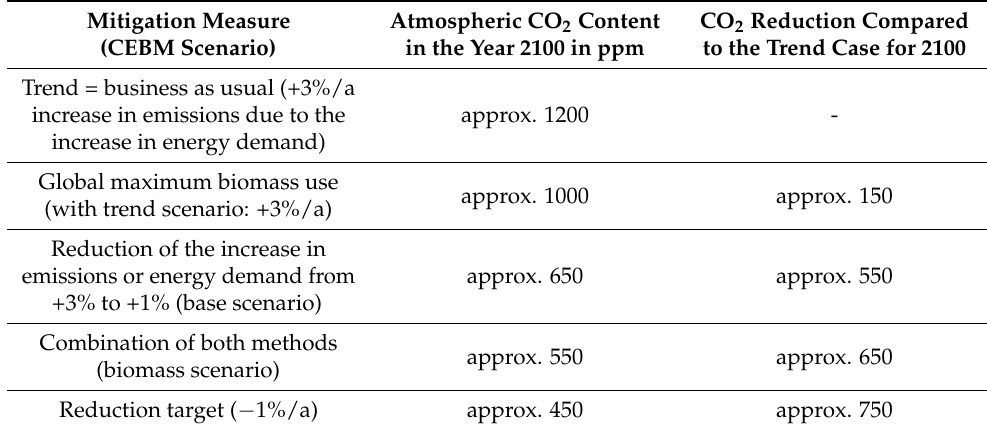
Table 2. Comparison of the CO 2 reduction by 2100 achievable by different measures as quantitatively evaluated by CEBM scenarios (see Figure